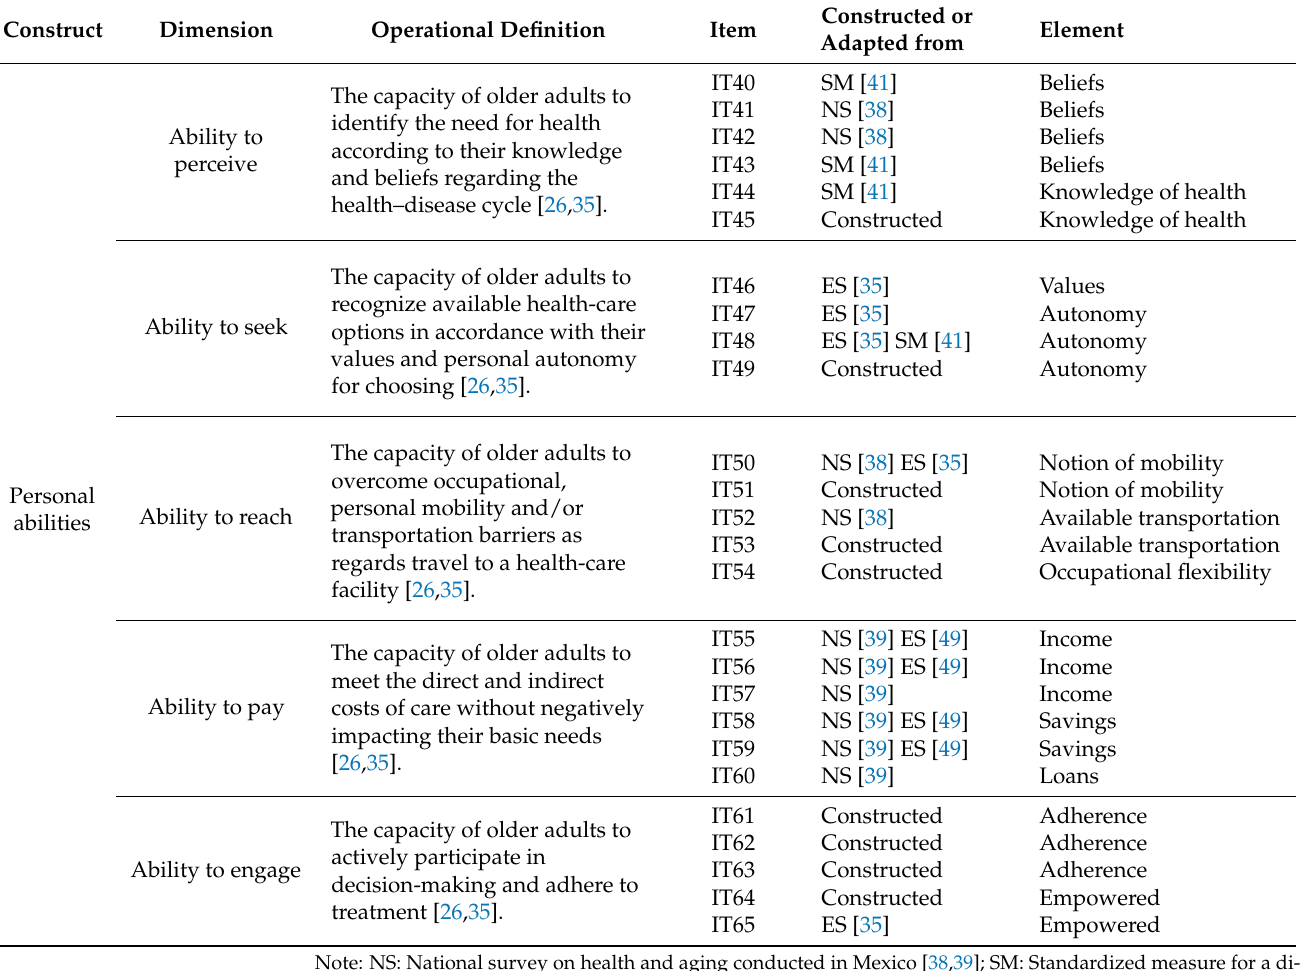
Table 2. List of items included in the scale according to the five dimensions of the personal abilities construct ( n =